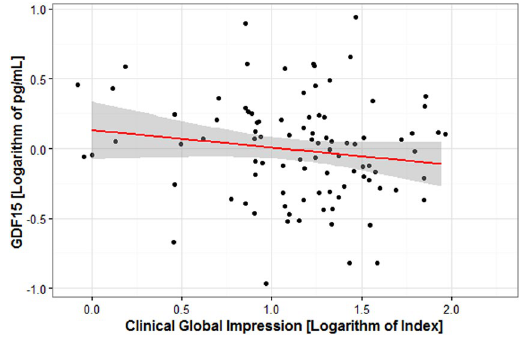
Figure 2. Plasma GDF15 levels are correlated with psychosis severity measured as Clinical Global Impression index (CGI) in psychosis patients. Higher CGI scores, representing more severe psychosis, were associated with lower GDF15 levels ( β standardized = − 0.221, t = − 2.58, p =